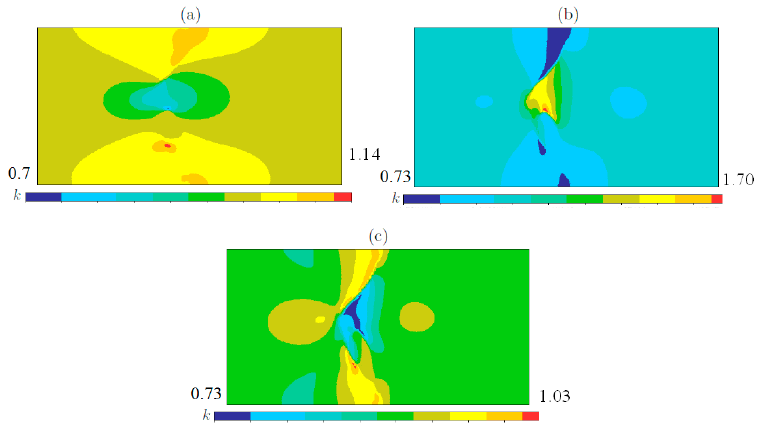
Figure 8. The von Mises stress concentration in the vicinity of the weld with crest: ( a ) tension along